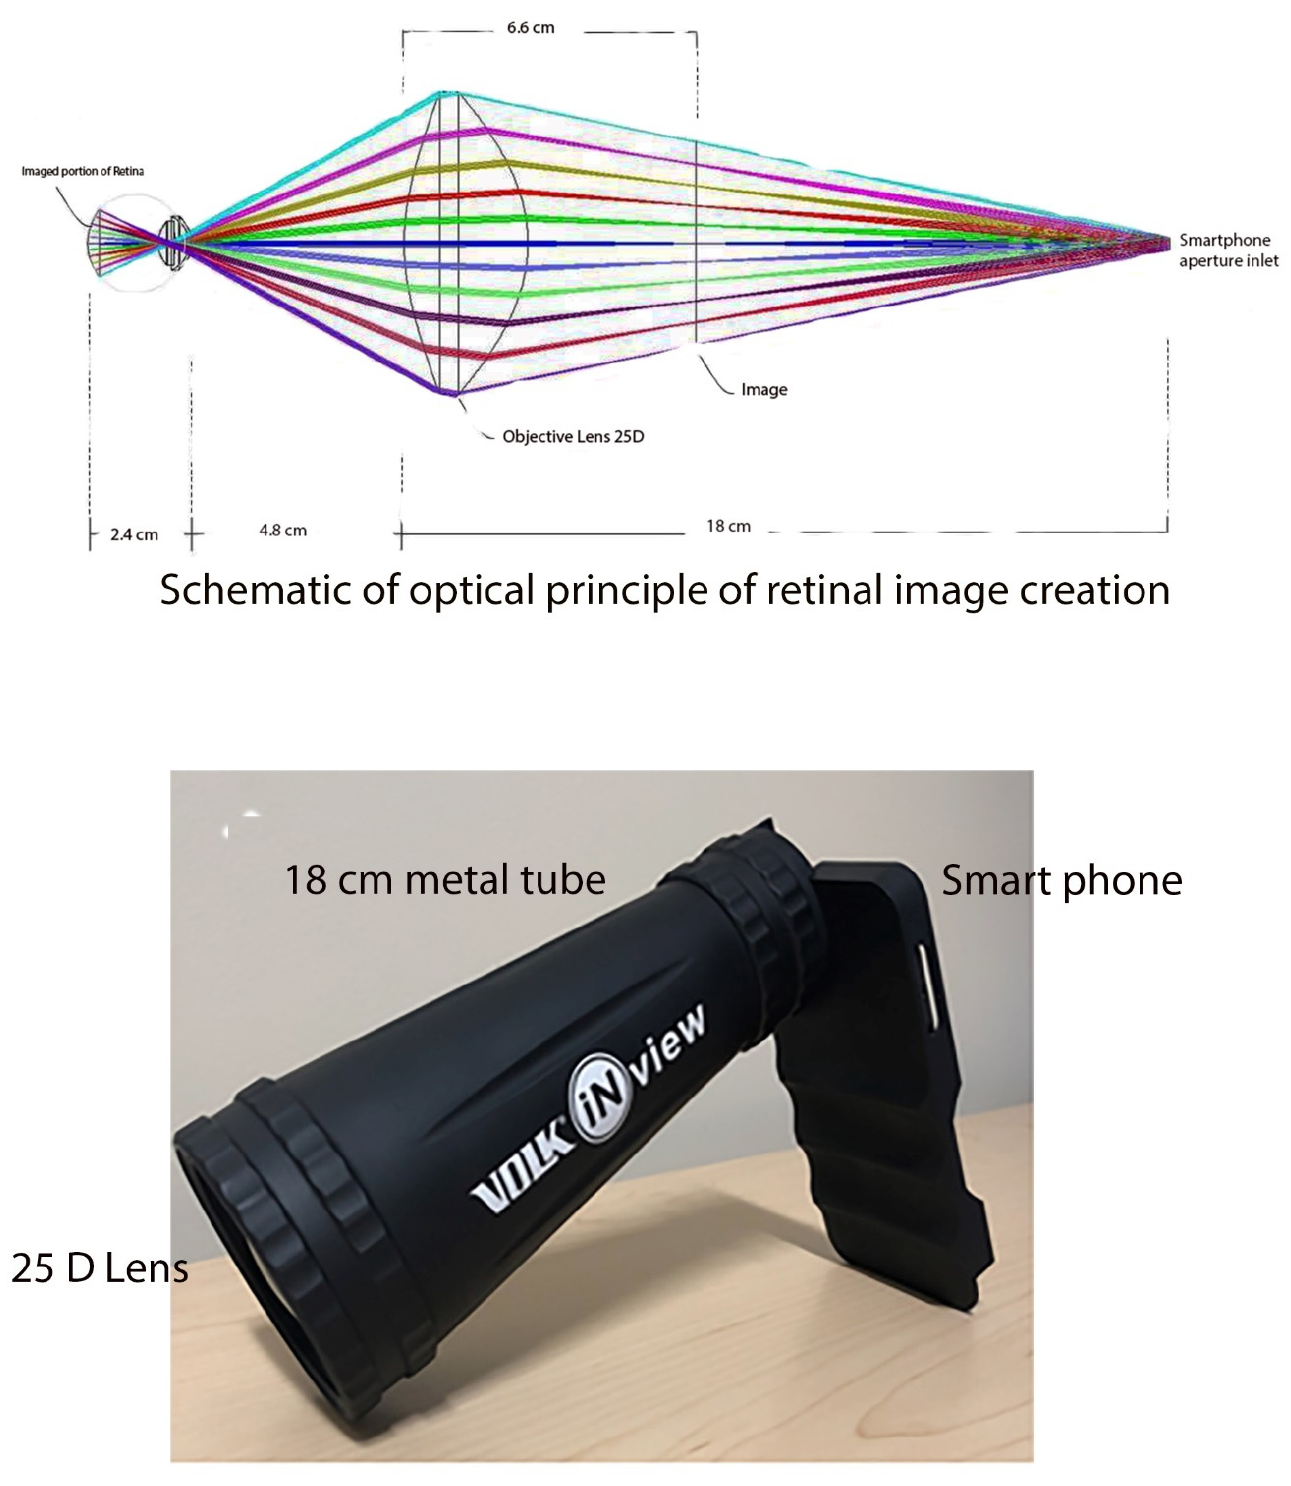
Figure 2. Housing and optical principles of smartphone retinal imager. The 25D condensing lens sits approximately 4.8 cm from the eye at the farthest end of the 18 cm metal tube, which is attached to the smartphone. The smartphone-based fundus camera allows for creation of an inverted, real aerial image approximately 6.6 cm from the condensing lens.